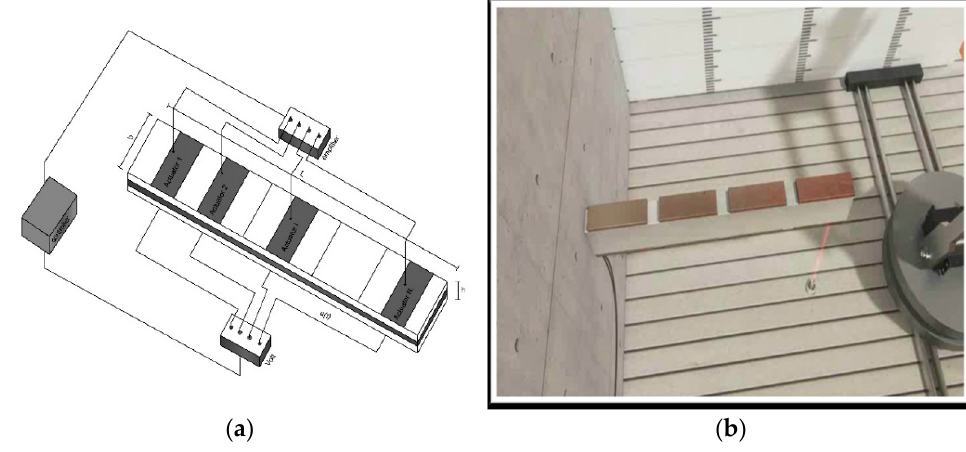
Figure 1. ( a ) Piezoelectric smart beam; ( b ) Piezoelectric smart cantilever beam. Table 1. Parameters of the smart beam. Parameters Values Beam length, L 0.8 m Beam width, W 0.07 m Beam thickness, h 0.0095 m Beam density, ρ